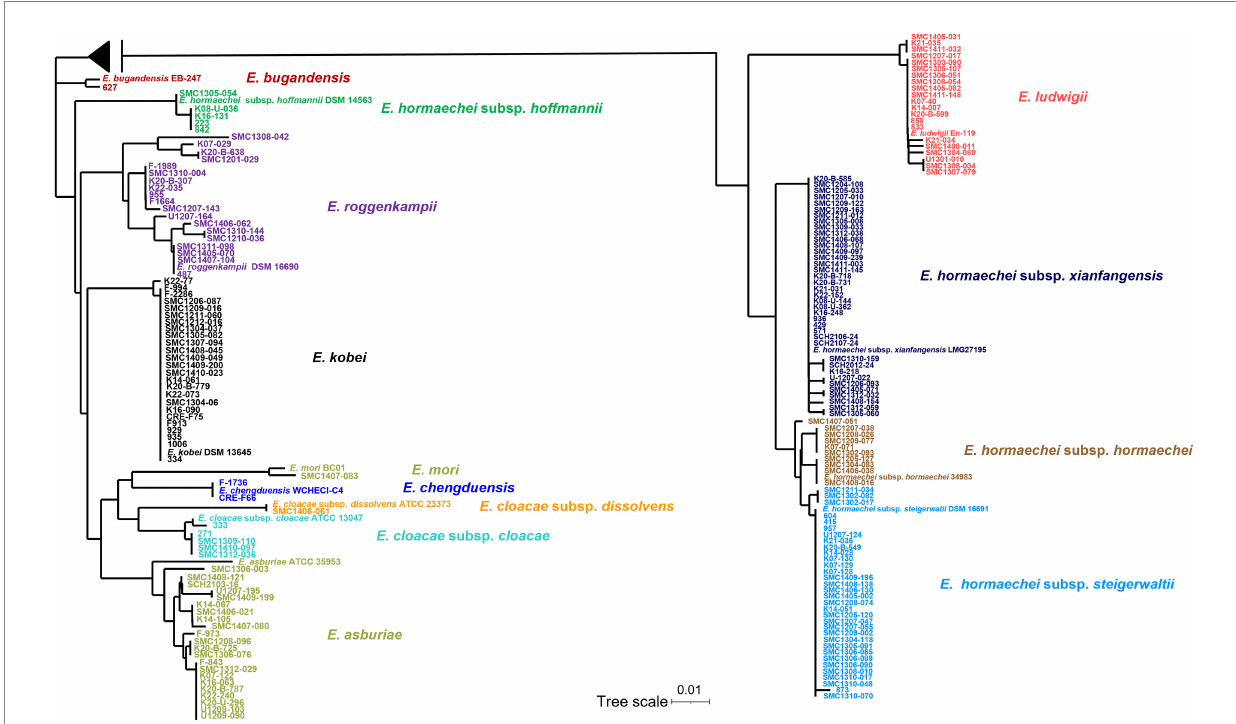
FIGURE 1 Phylogenetic tree based on neighbor-joining method using hsp60 gene sequences of 183 clinical isolates and reference strains of Enterobacter cloacae complex (ECC). The sequences of the isolate and the reference strains were aligned using ClustalW option of mega 7.0 software program. A midpoint rooting option was applied to root the tree due to the absence of a reliable outgroup. The branch lengths are proportional to the changes in the nucleotides. Scale par indicates one substitution per 100 nucleotides.